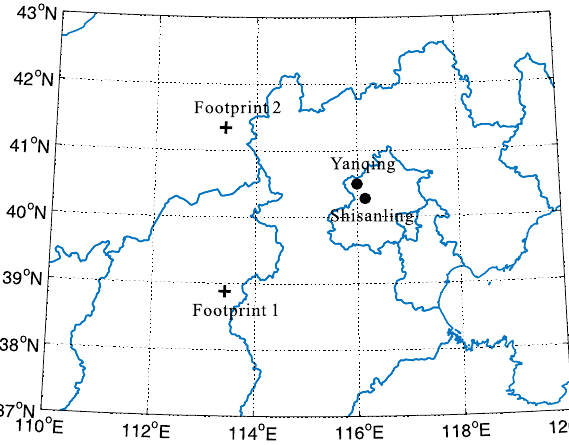
Figure 1. Map showing the station locations and the footprints of TIMED/SABER. The observation stations marked with black dots are Yanqing (40.5° N, 116° E) and Shisanling (40.3° N, 116.2° E). Satellite footprints marked with crosses are footprint 1 (38.87° N, 113.49° E) and footprint 2 (41.27° N, 113.44° E).